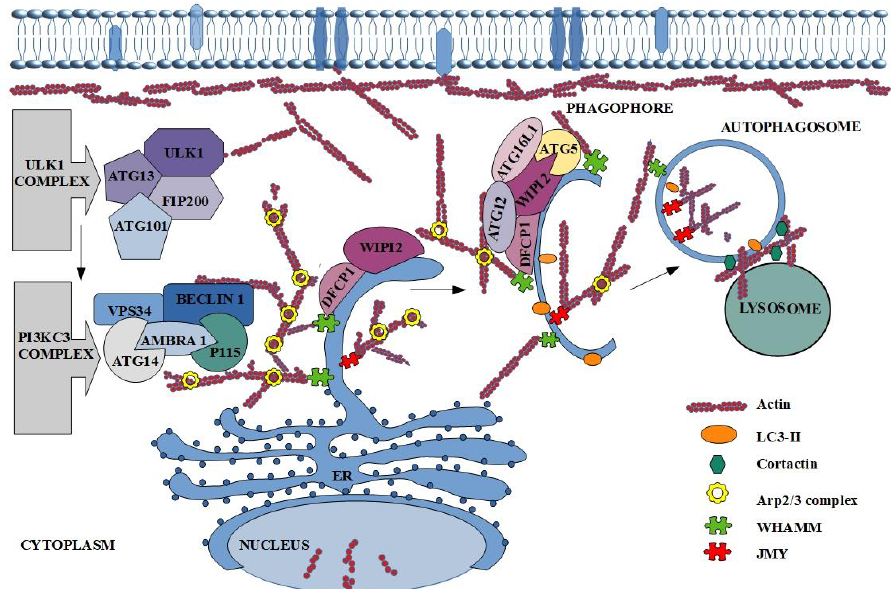
Figure 2. The participation of actin in autophagy process. The description of the figure can be found in the text above.